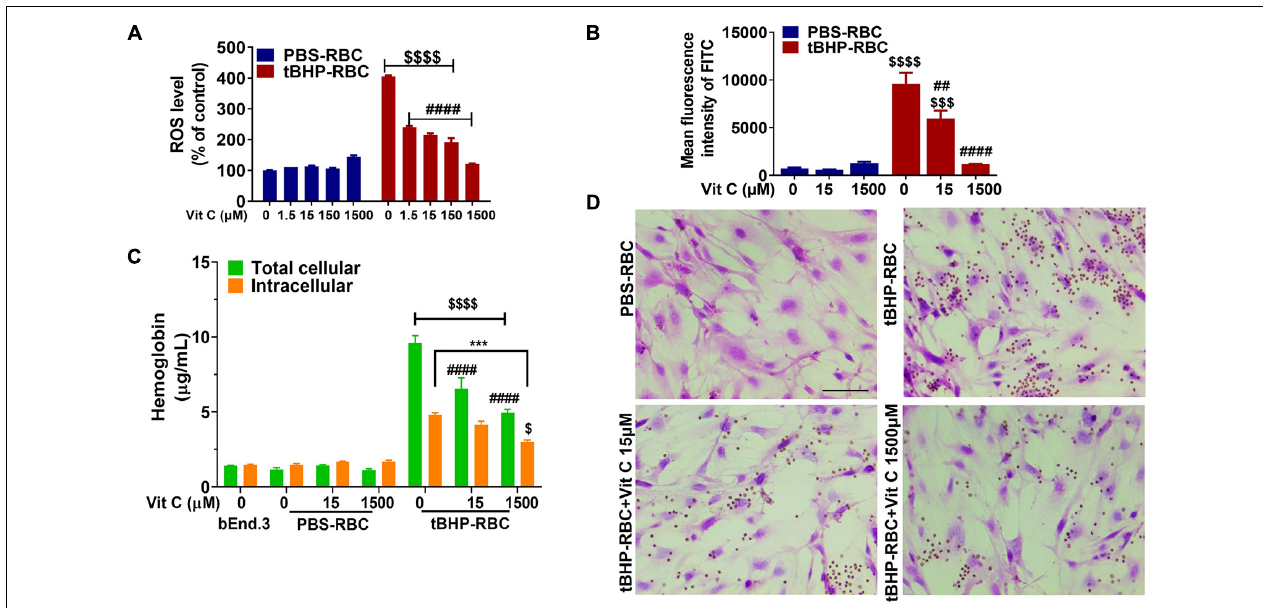
FIGURE 4 | Vitamin C (Vit C) reduced brain endothelial erythrophagocytosis. ROS level (A) and phosphatidylserine exposure (B) were suppressed by Vit C (15–1,500 µ M) after incubation with tBHP-RBCs. The total cellular and intracellular hemoglobin levels of bEnd.3 cells treated with tBHP-RBCs were significantly reduced following a 48-h incubation with Vit C (C) . Representative H&E-stained images of bEnd.3 cells following the 48-h incubation with Vit C-treated RBCs (D) . RBCs are seen as small red/brown dots, and bEnd.3 nuclei are stained purple with hematoxylin in panel (D) . Data are presented as mean ± SEM of three independent experiments done in duplicate. Two-way ANOVA with Holm–Sidak post hoc test was used. *** p < 0.001 as indicated. ## p < 0.01, #### p < 0.0001 compared with the corresponding tBHP-RBC + Vit C 0 µ M group. $ p < 0.05, $$$ p < 0.001, $$$$ p < 0.0001 tBHP-RBC group compared with the corresponding PBS-RBC and bEnd.3-only